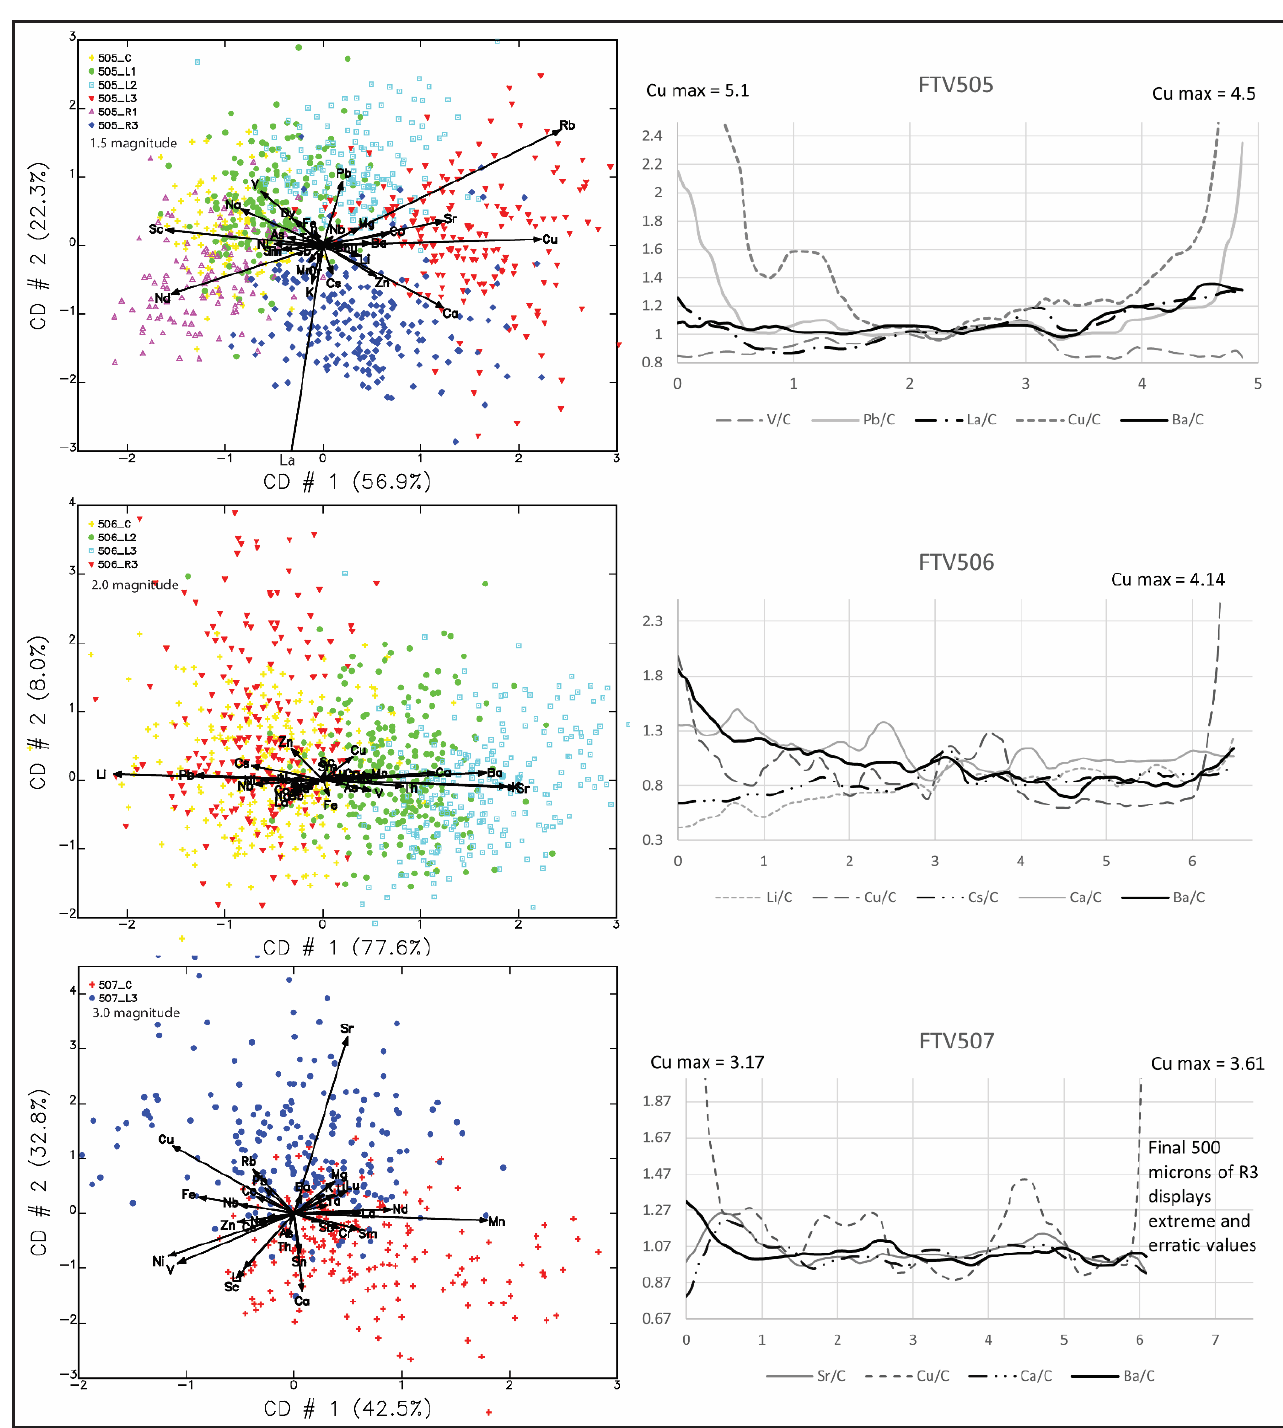
Figure 14. ( Left ) Canonical discriminant analysis of trimmed data points coded by zone (zones that do not diverge from the core not shown). ( Right ) Profiles of trimmed and smoothed data for elements that show significant zonal patterning. The x-axis is the position in the cross-section of the sherd in millimeters; the y-axis is the concentration of elements (in μg/g) expressed as a ratio to the average core concentration for the same element.